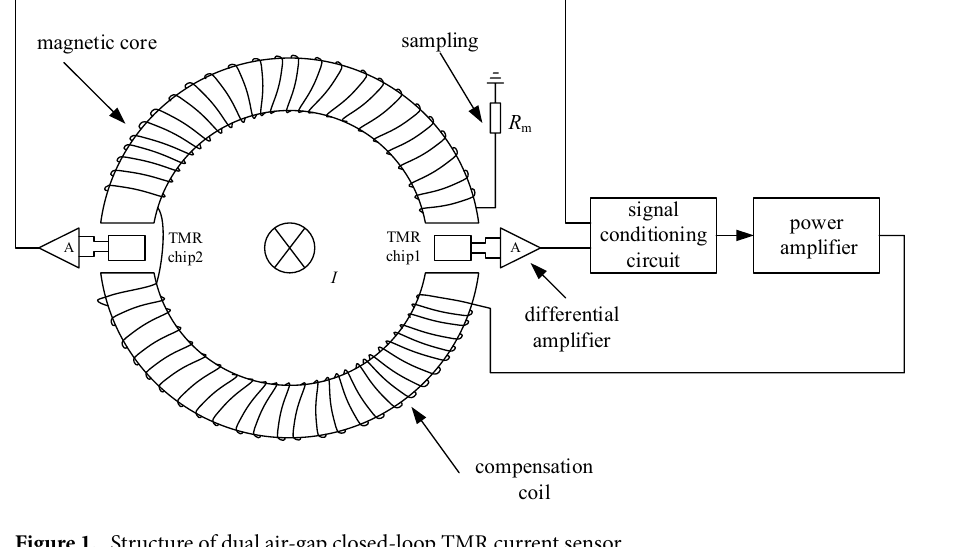
Figure 1. Structure of dual air-gap closed-loop TMR current sensor.